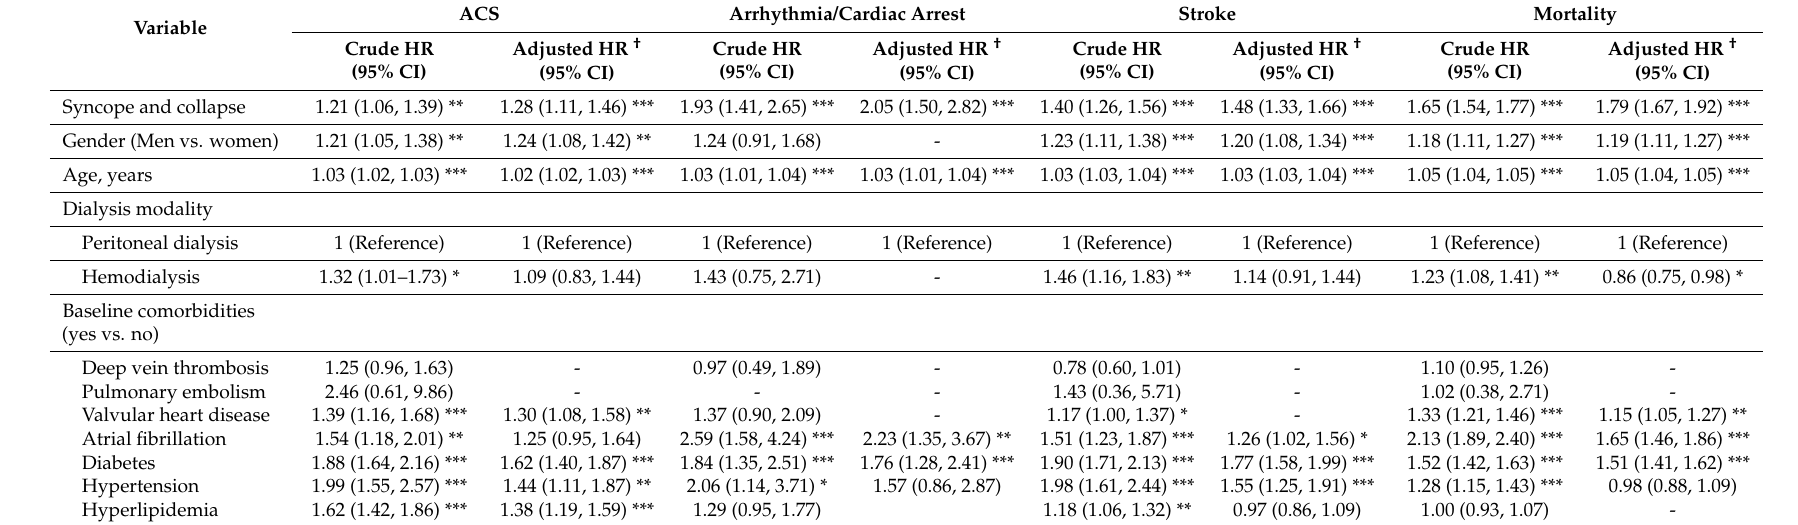
Table 2. Hazard ratios (HRs) of outcomes in association with sex, age, and comorbidities in univariate and multivariate Cox regression models.